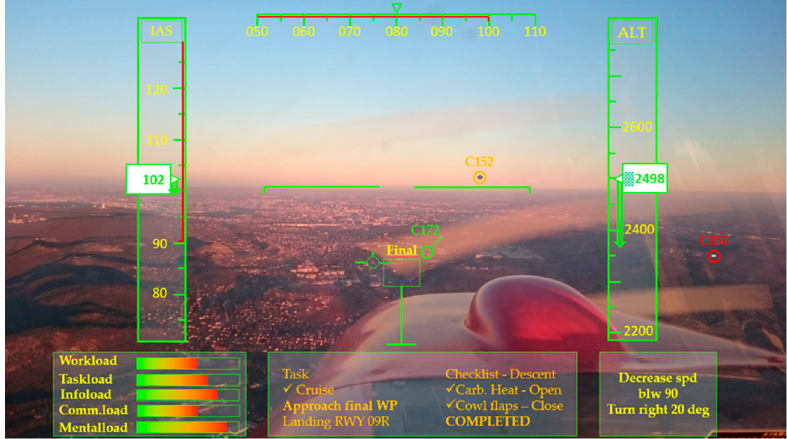
Figure 16. Future load monitoring and management design in the cockpit.